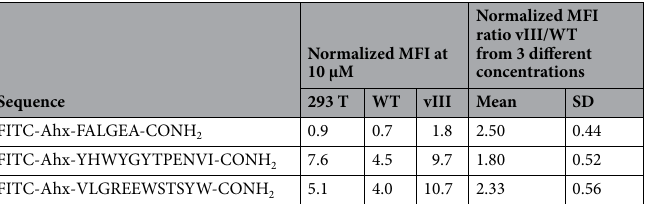
Table 1. Normalized MFI values and vIII/WT ratios for each peptide and each cell line obtained by flow cytometry.